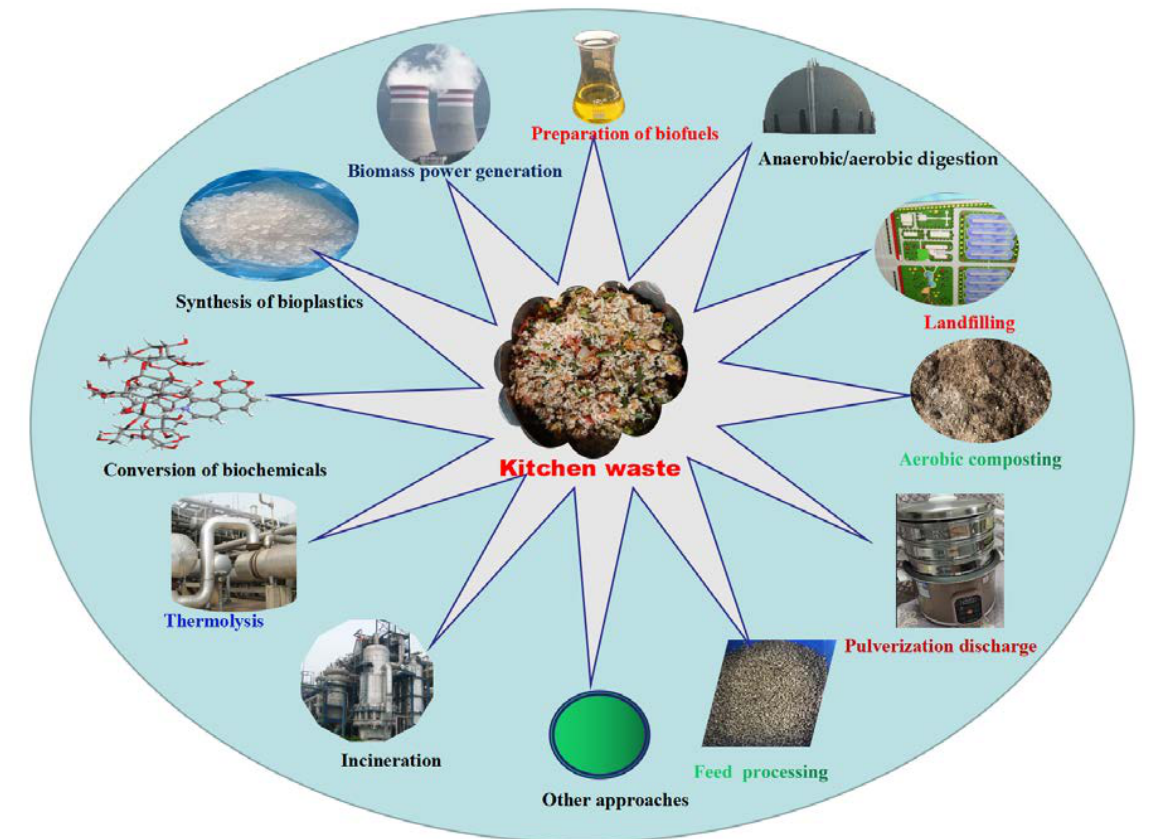
Figure 1. Common disposal and utilization methods of kitchen waste.